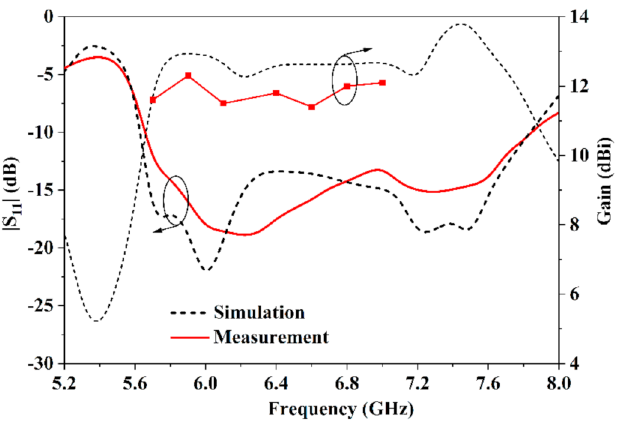
Figure 15. Reflective coefficients and gain of the proposed